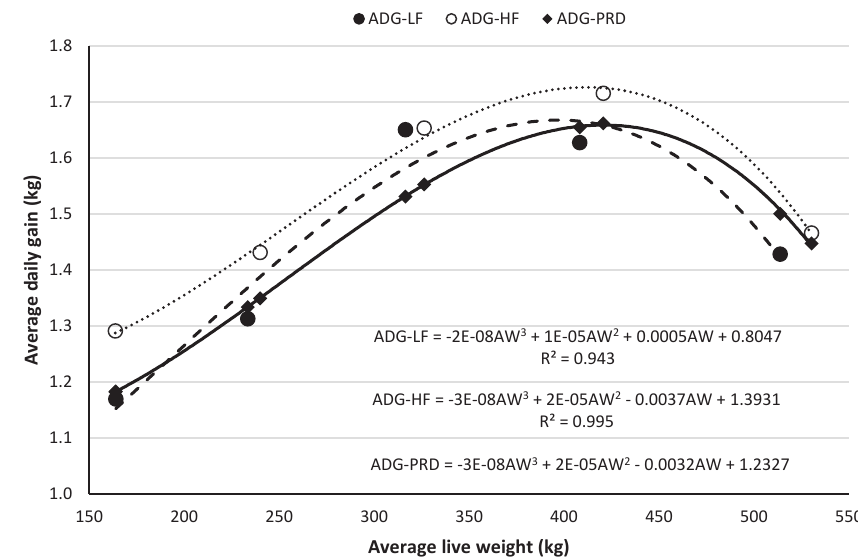
Figure 1. Treatment effects on average daily weight gain (ADG). ADG-LF, lower fiber diet; ADG-HF, higher fiber diet; ADG-PRD, generalized projected ADG based on Torrentera et al [18].